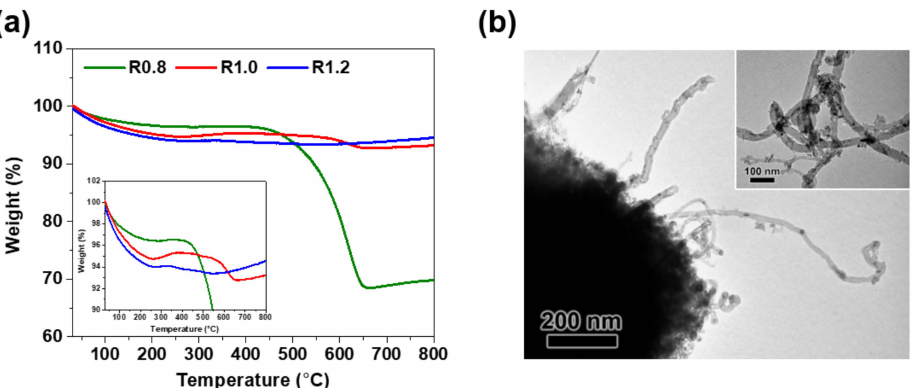
Figure 6. ( a ) TGA profiles of the spent catalysts after 10 h of DRM reaction, ( b ) Transmission Electron Microscopy (TEM) images of the spent catalyst after 10 h of dry reforming